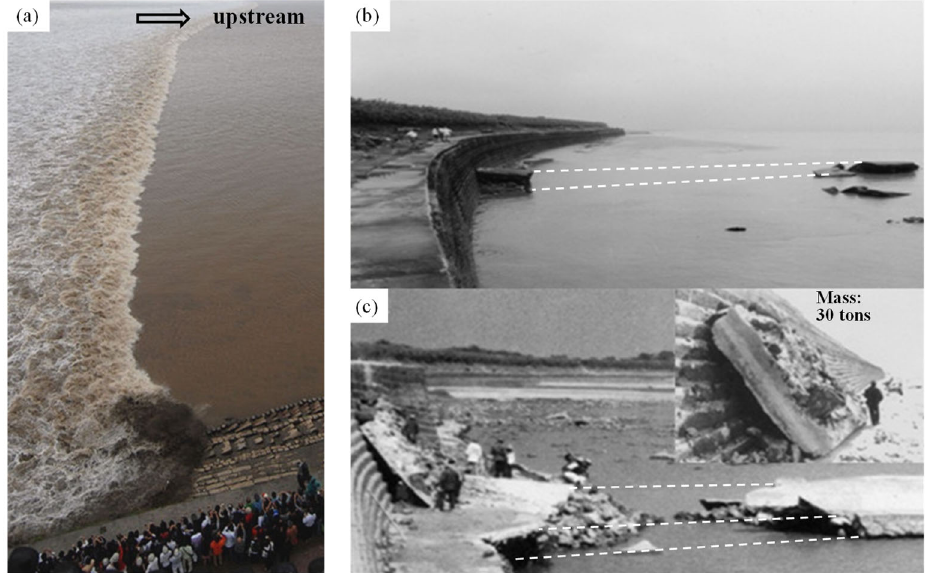
Figure 1. Damages to a spur dike caused by tidal bores: ( a ) a tidal bore propagating upstream; ( b ) destroyed spur dike; and ( c ) overturned concrete armor (inset: concrete armor against the seawall moved by a tidal bore).